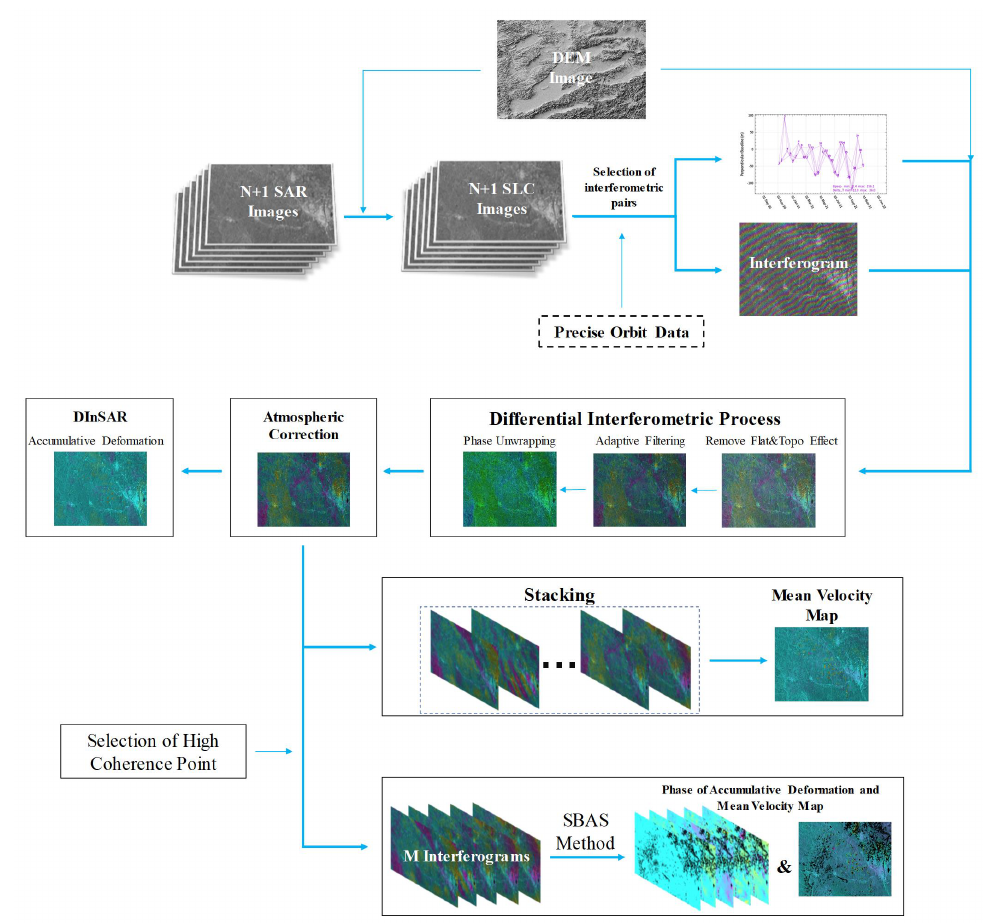
Figure 1. Flow chart of deformation monitoring.